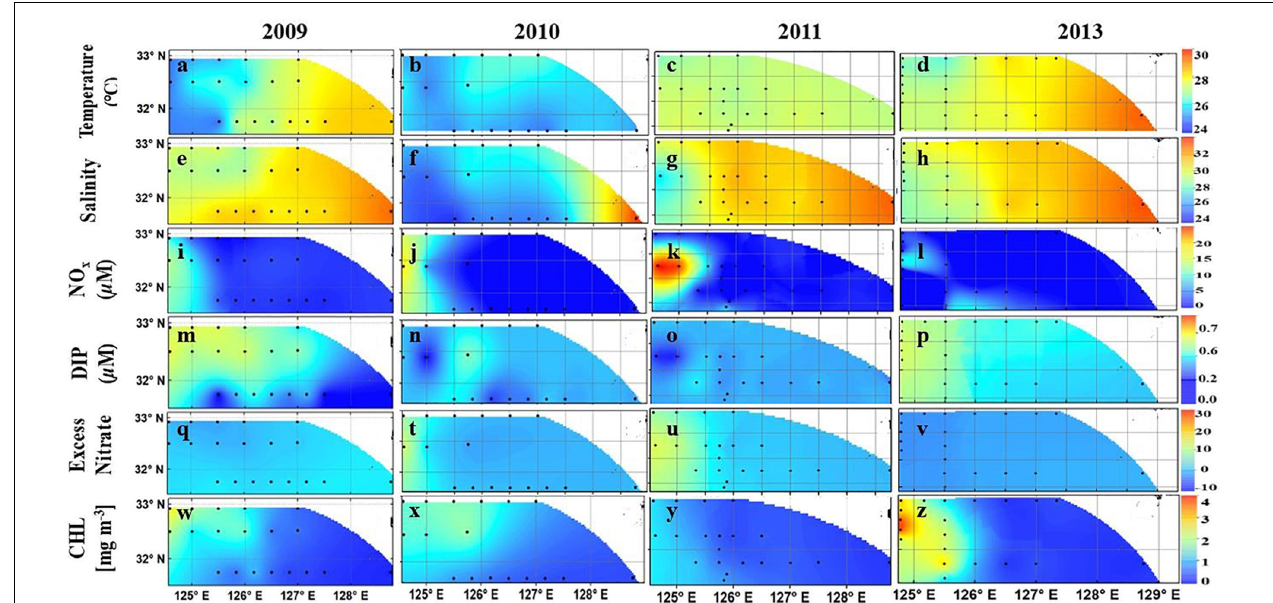
FIGURE 5 | (a–x) . Surface distribution of Temperature (a–d) , salinity (e–h) , DIN (i–l) , DIP (m–p) , ExN (q–v) , and Chl a (w–z) in the East China Sea from 2009 to 2011 and 2013. Black dots are sampling stations. Redrawn from Xu et al.